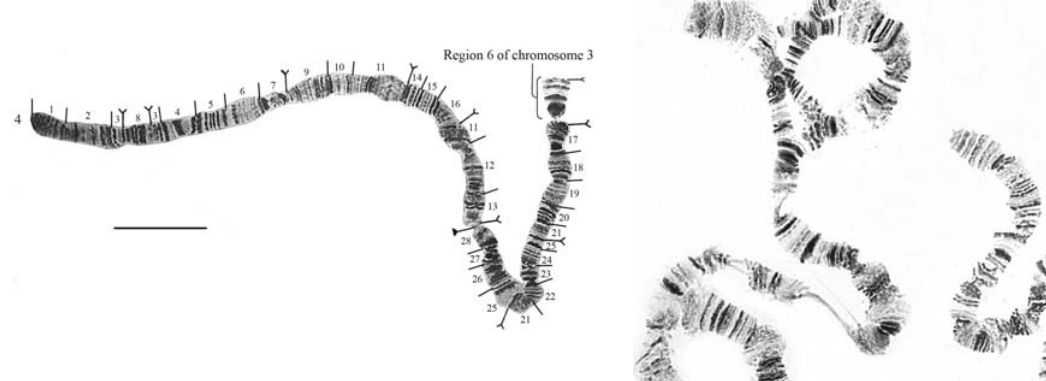
Figure 12 - Photomicrograph of chromosome 4 of Drosophila arapuan with part of region 6 of chromosome 3 attached to its extremity. This seg- ment also occurred isolated. Scale bar = 30 μ